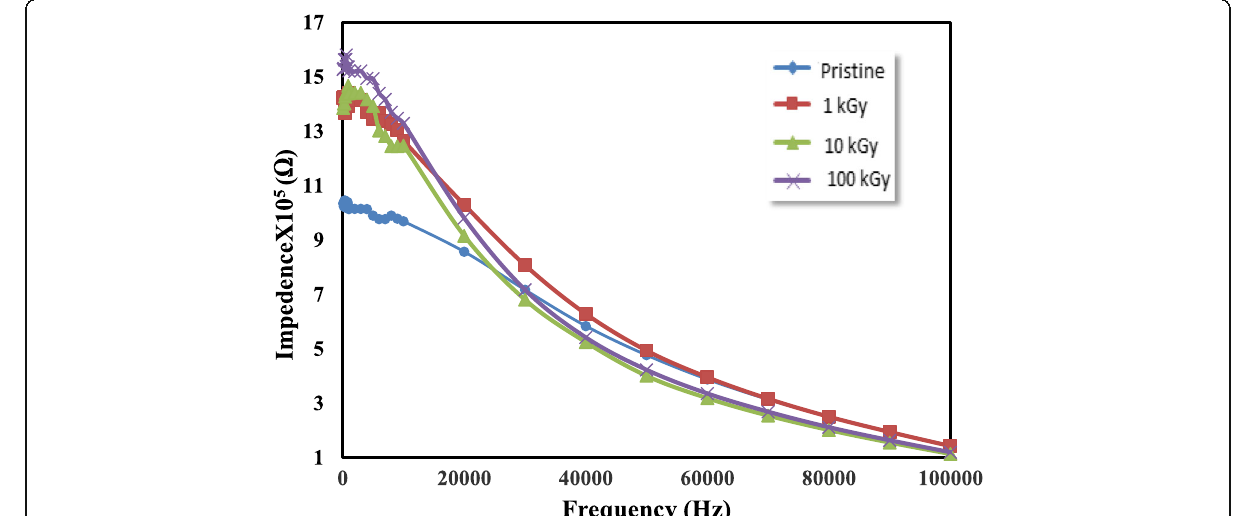
Fig. 4 Impedance versus frequency for Makrofol DE 1-1 polymer irradiated by different gamma